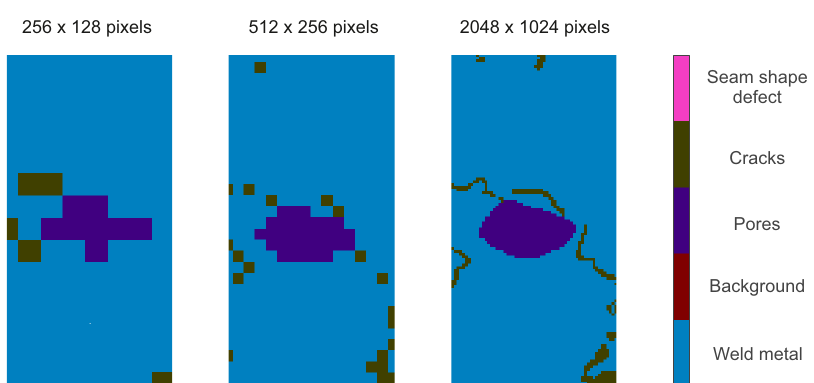
Figure 6. Comparison of labeled micrographs with different image resolutions.